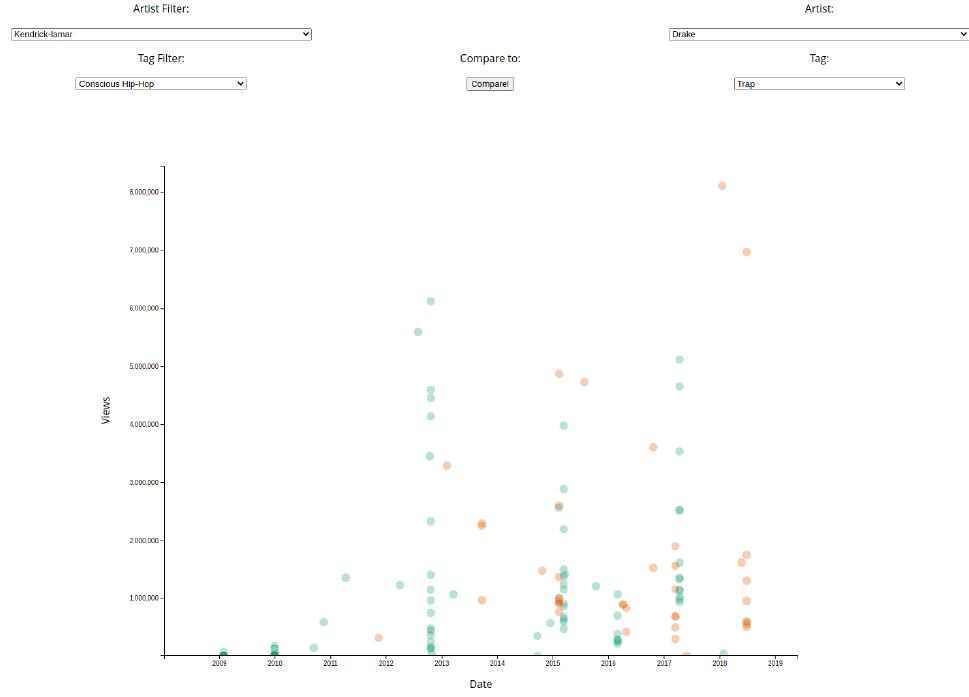
Figure 8. The scatterplot compares Kendrick Lamar’s conscious hip-hop tracks with Drake’s trap songs from 2009 to 2019 in terms of views and release